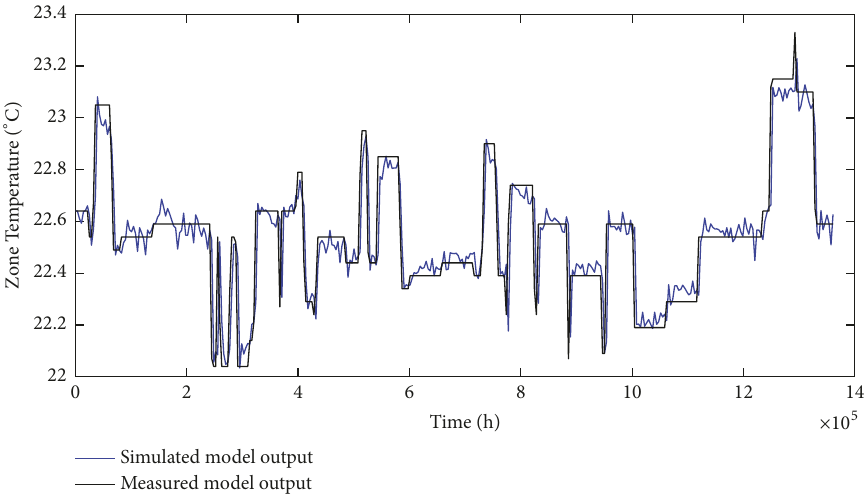
Figure 25: Validation of real measurements and outputs of zone temperature model fit 57%.